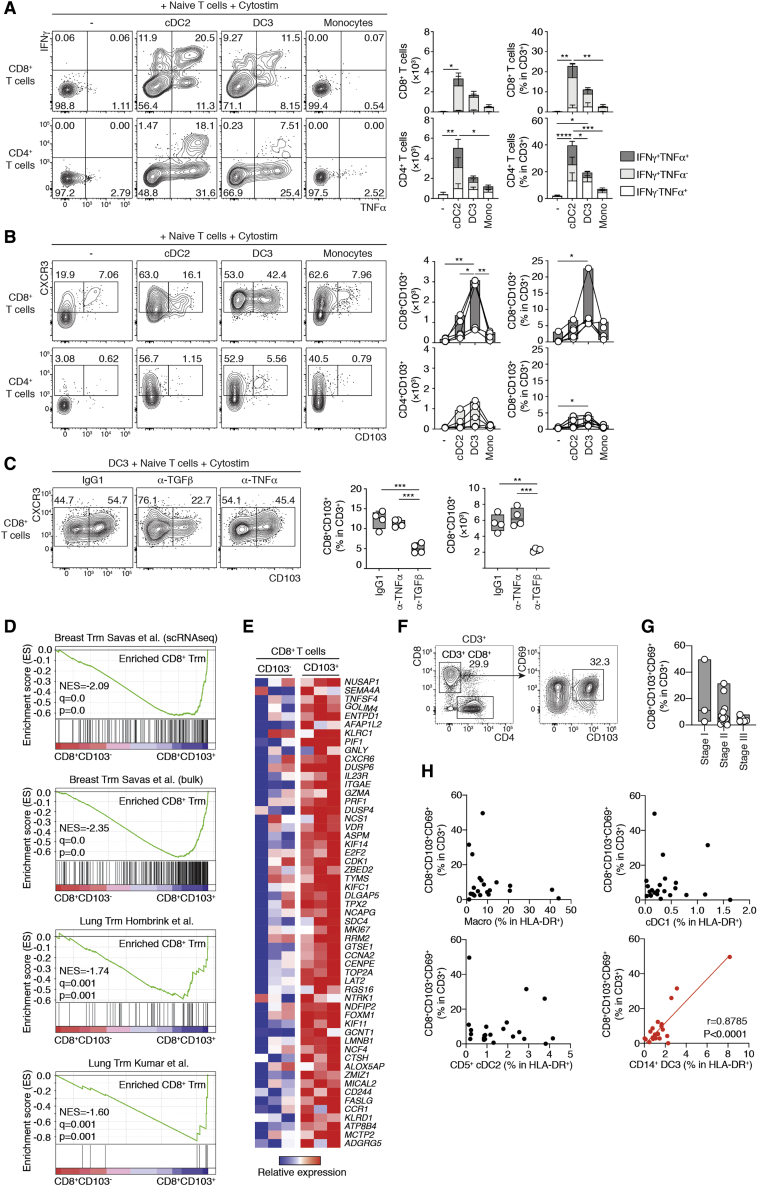
DC3s Prime Naive T Cells and Drive Acquisition of the CD103+ TRM Phenotype(A and B) Representative flow cytometry plots and quantification of CD4+ and CD8+ naive T cells cultured for 5 days with flow cytometry-sorted blood cDC2s, DC3s, or CD14+ monocytes after overnight activation with TLR agonists (25 μg/mL poly(I:C), 1 μg/mL R848, and 10 ng/mL LPS) in the presence of a synthetic superantigen (Cytostim). Absolute numbers and frequencies of cytokine-producing and other activated T cells (A) and CD103+ T cells (B) are shown (n = 5 healthy donors in 5 independent experiments; a line represents the median; ∗p < 0.05, ∗∗p < 0.01, ∗∗∗p < 0.001, ∗∗∗∗p < 0.0001, one-way ANOVA test).(C) Representative flow cytometry plots and quantification showing CD103 expression on CD8+ naive T cells cocultured with blood DC3s sorted by fluorescence-activated cell sorting (FACS) in the presence of 10 μg/mL of neutralizing antibodies against TNF-α or TGF-β or an isotype CTRL (n = 4 healthy donors in 3 independent experiments; a line represents the median; ∗p < 0.05, ∗∗p < 0.01, ∗∗∗p < 0.001, ∗∗∗∗p < 0.0001, one-way paired ANOVA test).(D and E) Bulk RNA-seq analysis of CD8+CD103− T cells (n = 3) and CD8+CD103+ T cells (n = 3) sorted by flow cytometry after 5 days in vitro coculture of naive blood CD8+ T cells with blood DC3s activated overnight by TLR agonists.(D) GSEA of pairwise comparisons of CD8+CD103+ T cells with CD8+CD103− T cells. Gene signatures (gene set) defining genes upregulated in breast or lung CD103+CD69+CD8+ TRM cells were used (Hombrink et al., 2016; Kumar et al., 2017; Savas et al., 2018).(E) Heatmap displaying 56 representative genes significantly upregulated in CD8+CD103+ cells compared with CD8+CD103− induced by blood DC3s in vitro (of 205 DEGs). Selected genes are shared with at least one of the previously reported gene signatures defining human TRM cells (Hombrink et al., 2016; Kumar et al., 2017; Savas et al., 2018).(F–H) Correlative analysis of TRM cell content in luminal breast cancer primary tumors.(F) Representative flow cytometry plots showing the gating strategy for CD103+CD69+CD8+ T cells in 21 human luminal breast cancer primary tumors.(G) Quantification of CD103+CD69+CD8+ T cells in different stages of human breast tumors (stage I, n = 3; stage II, n = 13; stage III, n = 5).(H) Pearson correlation of the frequencies of the macrophages and cDC1, CD1c+ CD14−, and CD1c+ CD14− cells and the frequencies of CD103+CD69+CD8+ T cells in human breast cancer primary tumors (red, significantly correlated p < 0.05; black, not correlated).See also Figure S7 and Tables S1 and S2.